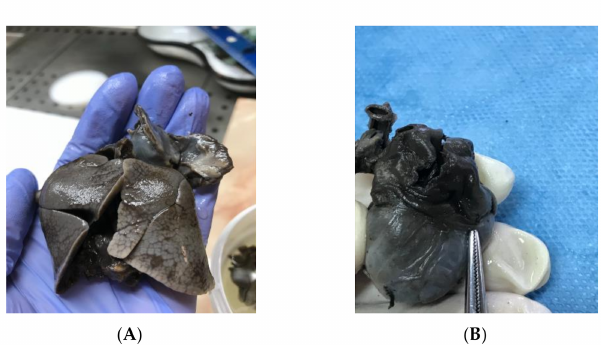
Figure 5. Macroscopical examination of the fetal heart and lungs during necropsy: ( A ) left atrial isomerism and bilobar lungs; ( B ) enlarged common